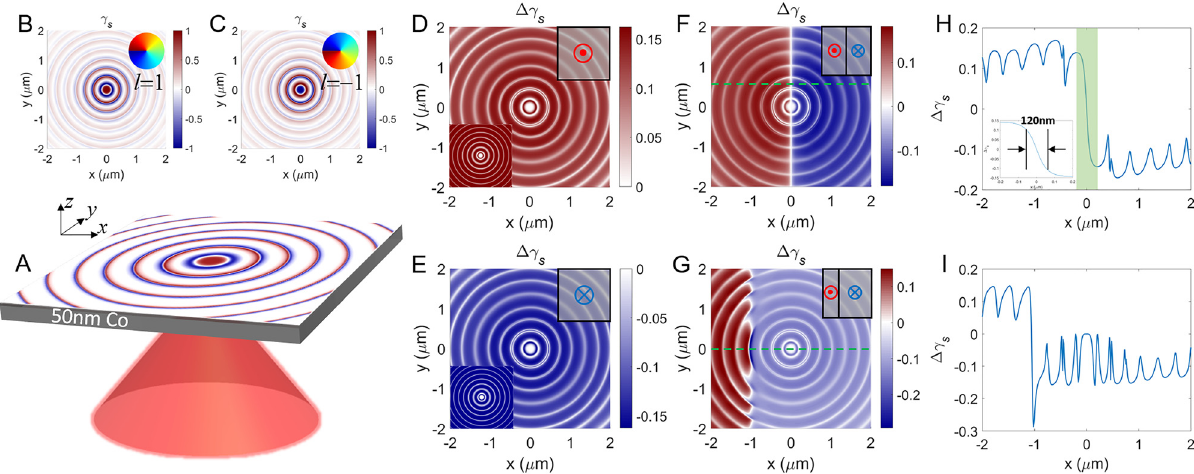
Figure 3: (A) Schematicdiagram for the generation of a photonic skyrmion in a ferromagnetic material on the exampleof the SPP excited on a surfaceof athin(50nm)Co fi lmbyatightlyfocused( NA =1.49)radiallypolarizedbeam.Incidentanglesbelow40 ° areblockedtostabilizethe generation of photonic skyrmions. The permittivity and the gyration vector constant of cobalt at wavelength of 633 nm are the same as in a Figure1.(B,C)Spinstatesof(B)positiveand(C)negativeskyrmionsgeneratedwith l = ± 1RPbeam,respectively,withtheComagnetizationina positive z direction.(D)Spatialdistributionof Δ γ s fortheskyrmionsin(B)and(C).Correspondingtheoreticaldistributionsof Δ γ s obtainedfrom Equation (9) is depicted in the bottom left inset. (E) The same as (D) for the magnetization oriented in negative z direction. (F,G) Spatial distributions of Δ γ s for the magnetic structure consisting of two domains with opposite magnetization orientation: the domain wall is at (F) x = 0 and (G) x = − 1 μ m. (H, I) Cross-sections marked in (F, G) with a green dashed line. Inset in (H) is a zoomed view of the spin structure of the area indicated with light green box in